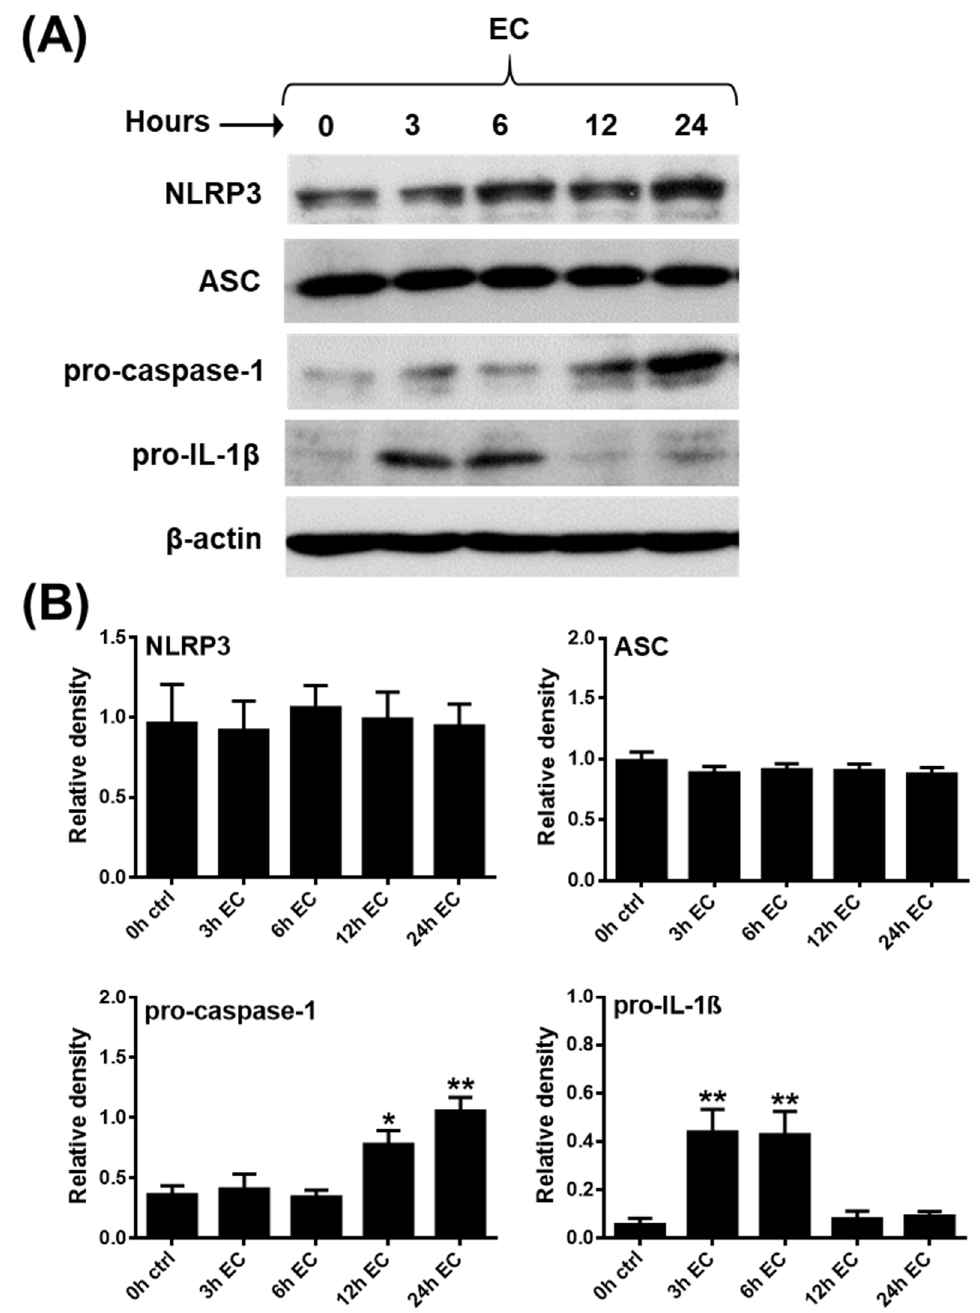
Figure 2. Pathogenic bacteria influence the expression of NLRP3 inflammasome pathway components in the human GEN2.2 pDC cell line. GEN2.2 cells were treated with E. coli (MOI 10) in a time- dependent manner ( A , B ). The expression of NLRP3, ASC, pro-caspase-1 and pro-IL-1 β was measured at the protein level by Western blotting. Representative blots are shown in ( A ). Data are shown as mean ± SD from 5 independent experiments in ( B ). Data were analyzed using one-way ANOVA followed by Bonferroni’s post-hoc test. * p < 0.05, ** p < 0.01 vs. control (ctrl). EC: E. coli .